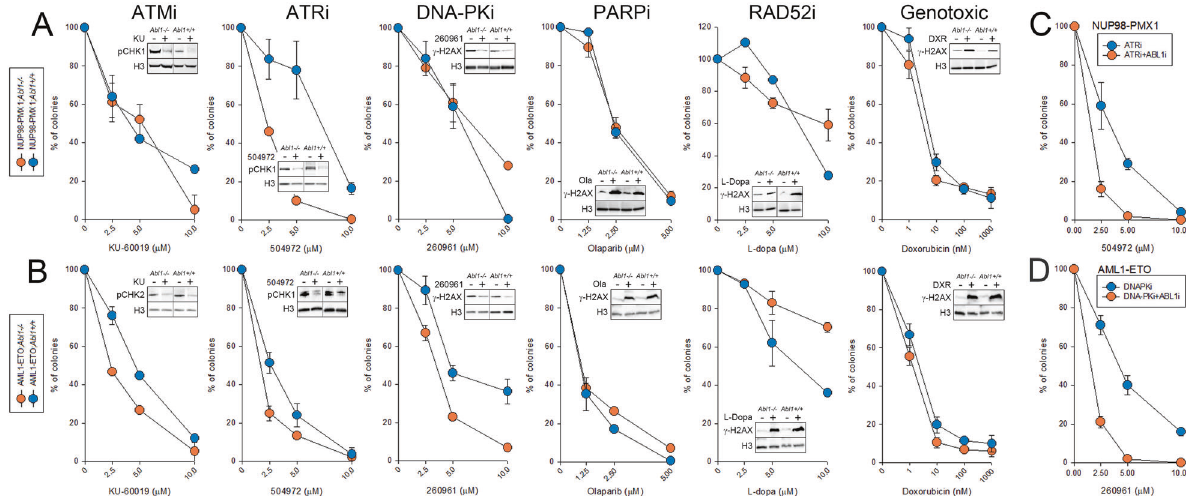
Fig. 4 The impact of ABL1 on response to the drugs affecting DDR. A Lin-c-Kit + NUP98-PMX1; Abl1 − / − and NUP98-PMX1; Abl1 + / + cells, and B Lin-c-Kit + AML1-ETO; Abl1 − / − and AML1-ETO; Abl1 + / + cells were treated with the indicated concentrations of doxorubicin, PARPi olaparib, RAD52i 6-hydroxy-DL-dopa, ATMi KU-60019, ATRi 504972 and DNA-PKcsi 260961. After 72 h cells were plated in methylcellulose and colonies were counted 7 days later. Results represent mean % ± SD of colonies when compared to untreated controls (3 independent experiments). Insets: cells were treated with the inhibitors for 24 h. Total cell lysates were analyzed by Western blot detecting indicated proteins (p = phosphorylated). C , D Lin-c-Kit + NUP98-PMX1; Abl1 + / + and AML1-ETO; Abl1 + / + cells were treated or not with 2 μ M ABL1i imatinib + /- the indicated concentrations of DNA-PKcsi and ATRi. After 72 h cells were plated in methylcellulose and colonies were counted 7 days later. Results represent mean % ± SD of colonies when compared to untreated controls (3 independent